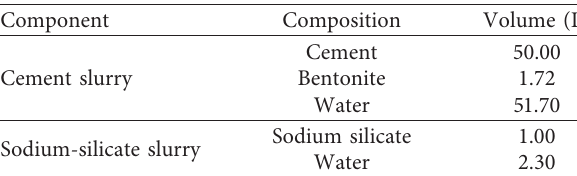
Figure 13: Amount of slurry injected into the last 15 rings. Table 2: Ratio of binary